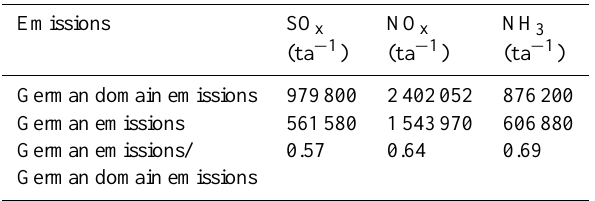
Table 2. Total annual German and German domain SO x , NO x and NH 3 emissions and the ratio of German emissions to German do- main emissions.